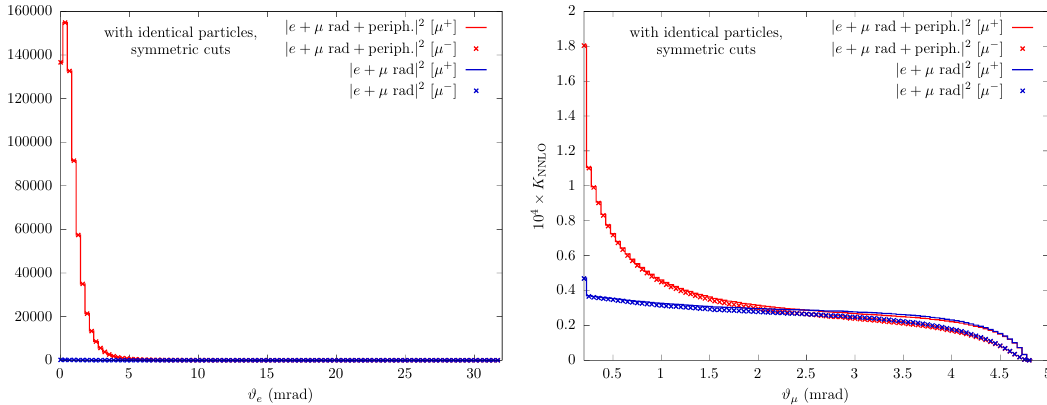
Figure 19. Differential K NNLO factor for θ e (left) and θ µ (right) distributions for real e + e − radiation with realistic event selection, without acoplanarity cut. θ